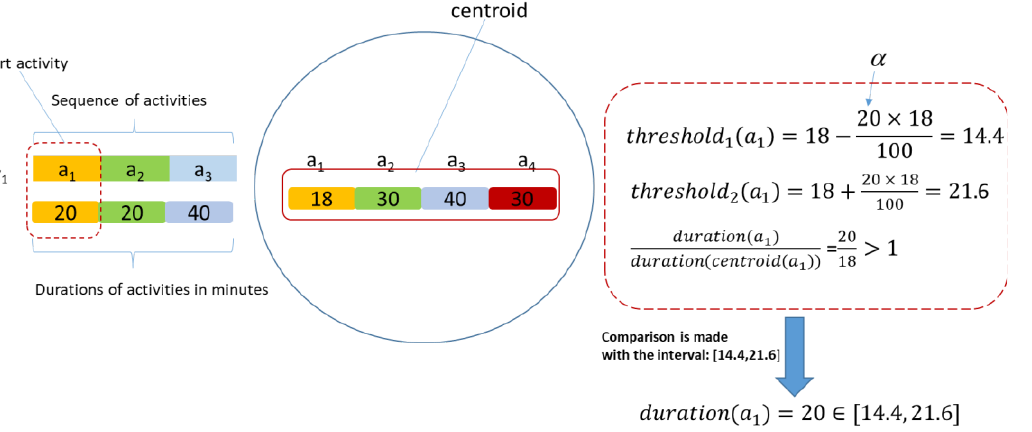
Figure 4. Timespan of an activity and clusters centroids. Example for computing the timespan for activity a 1 .